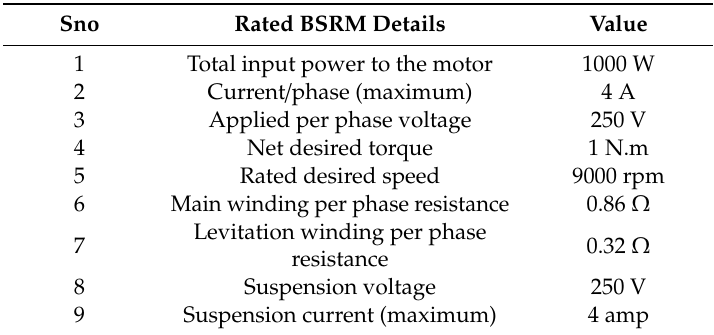
Table 2. Operating details of 12 / 14